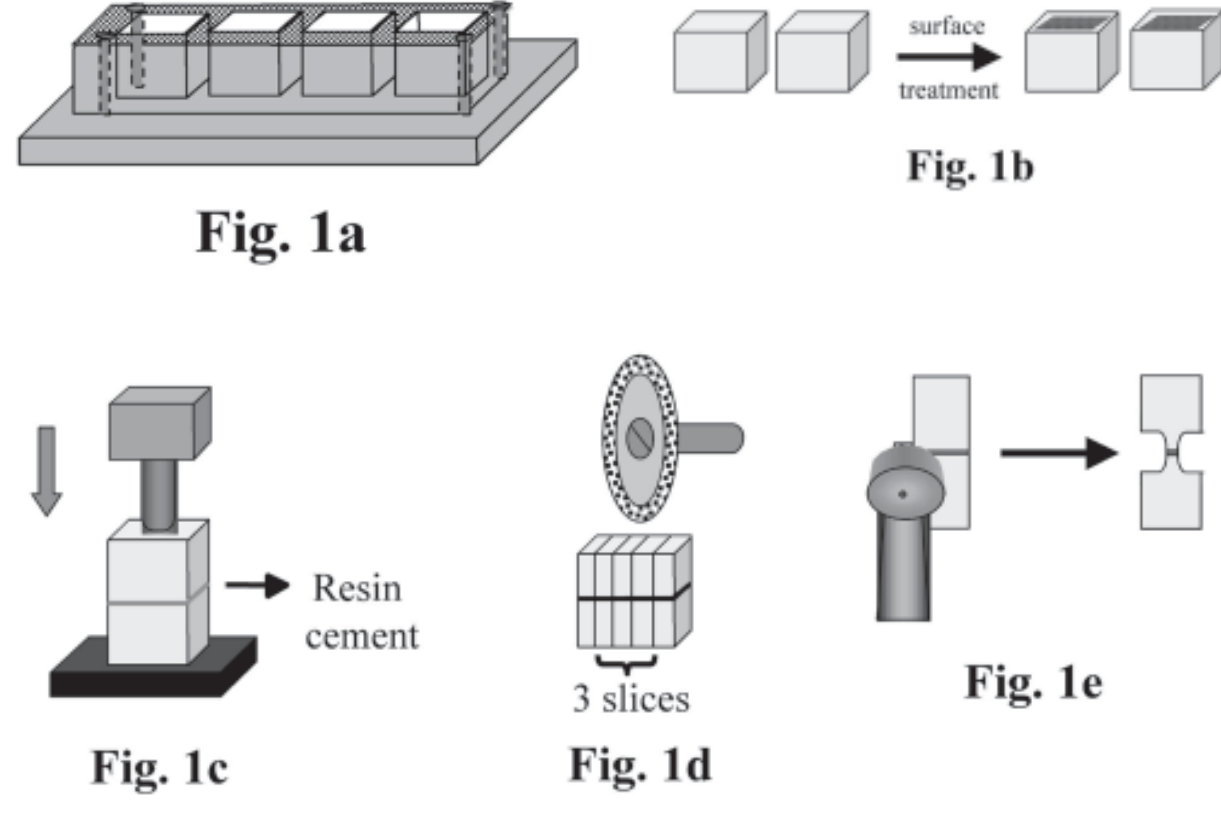
FIGURE 1 - Schematic diagram of the specimen